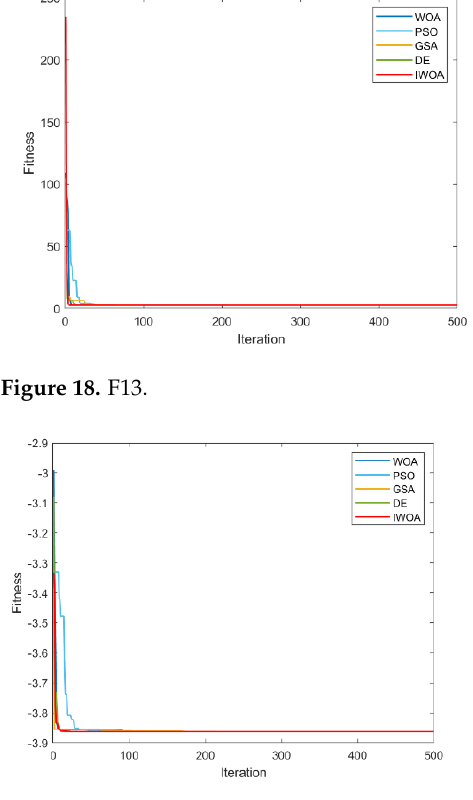
14 of 26 Figure 15. F10. Figure 16. F11.